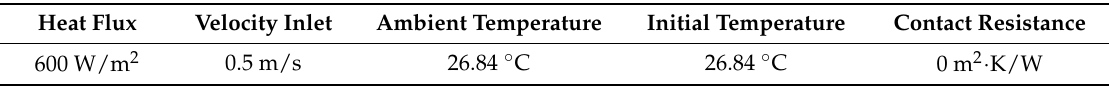
Table 4. Thermal properties .